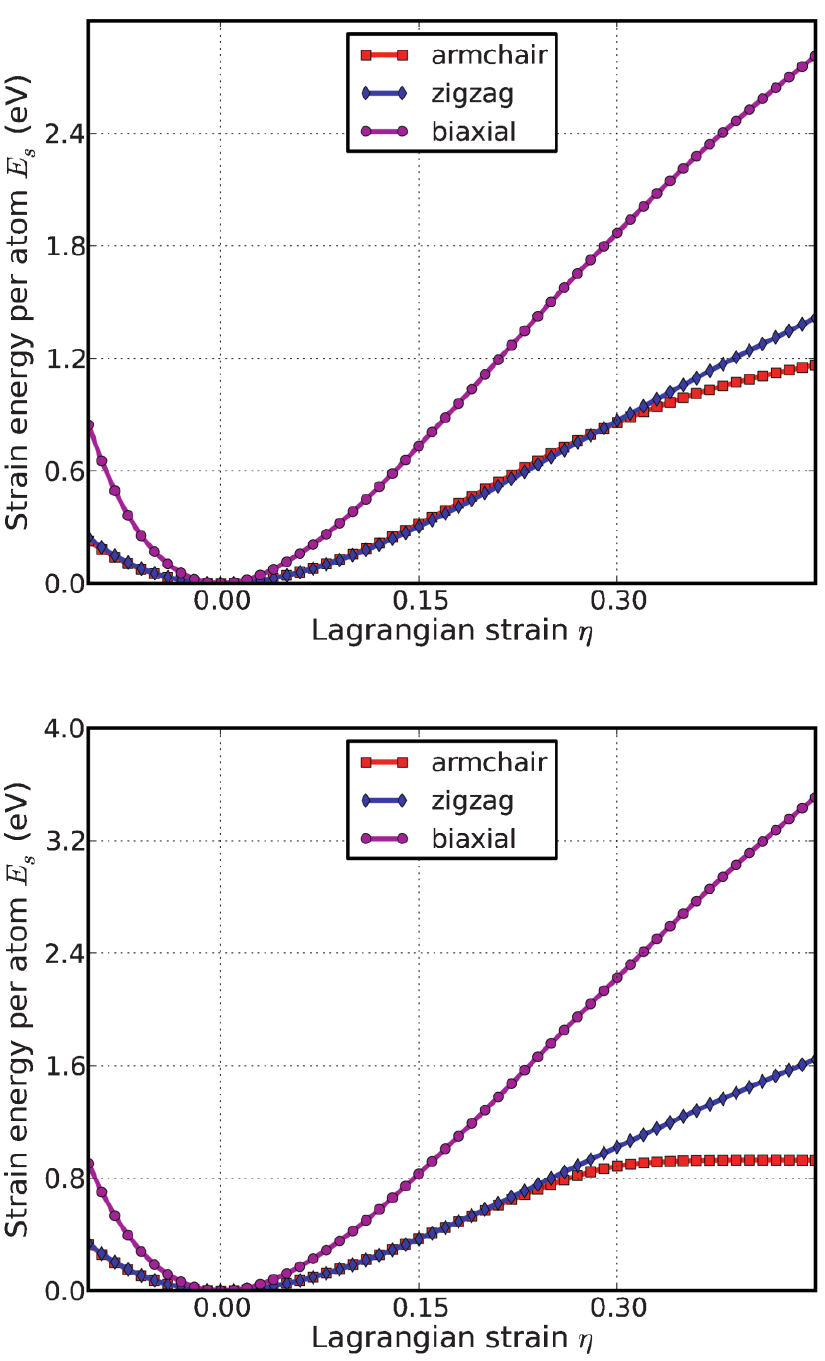
Figure 9. Energy – strain responses for uniaxial strain in armchair and zigzag directions, and equibiaxial strains of g-AlN ( top ), compared with g-BN ( bottom ).